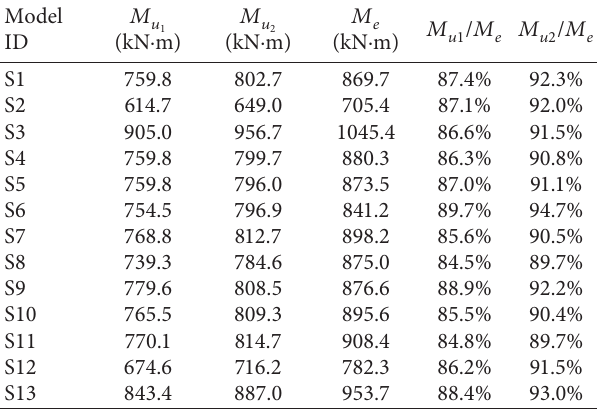
Table 4: Comparison of theoretical and FE results.